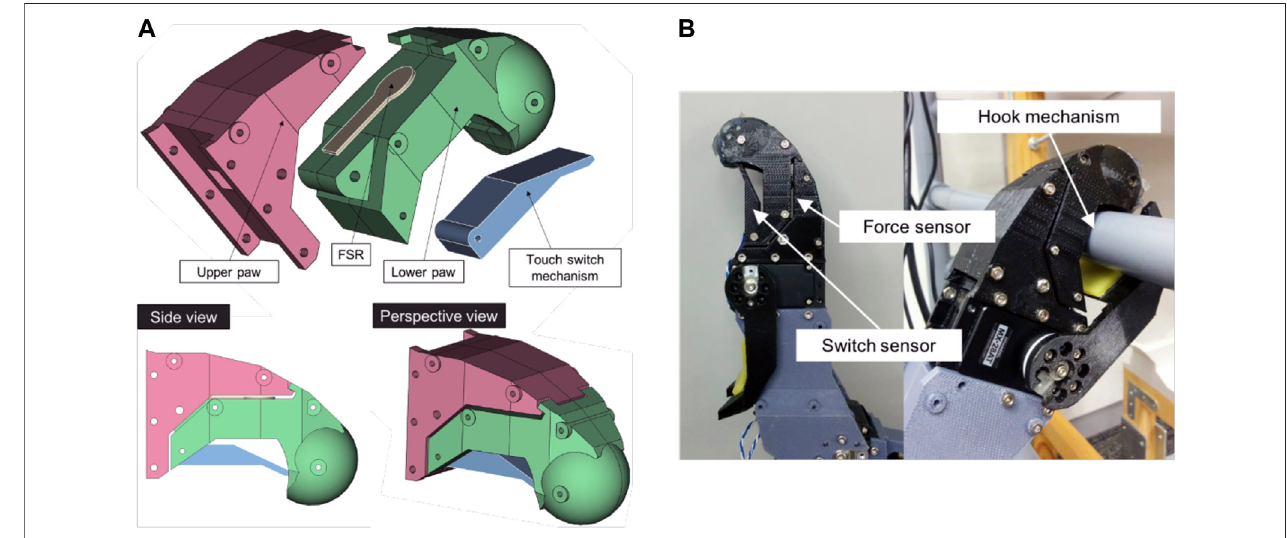
FIGURE 4 | The end effector. (A) CAD drawings (B) The 3D-printed effector.